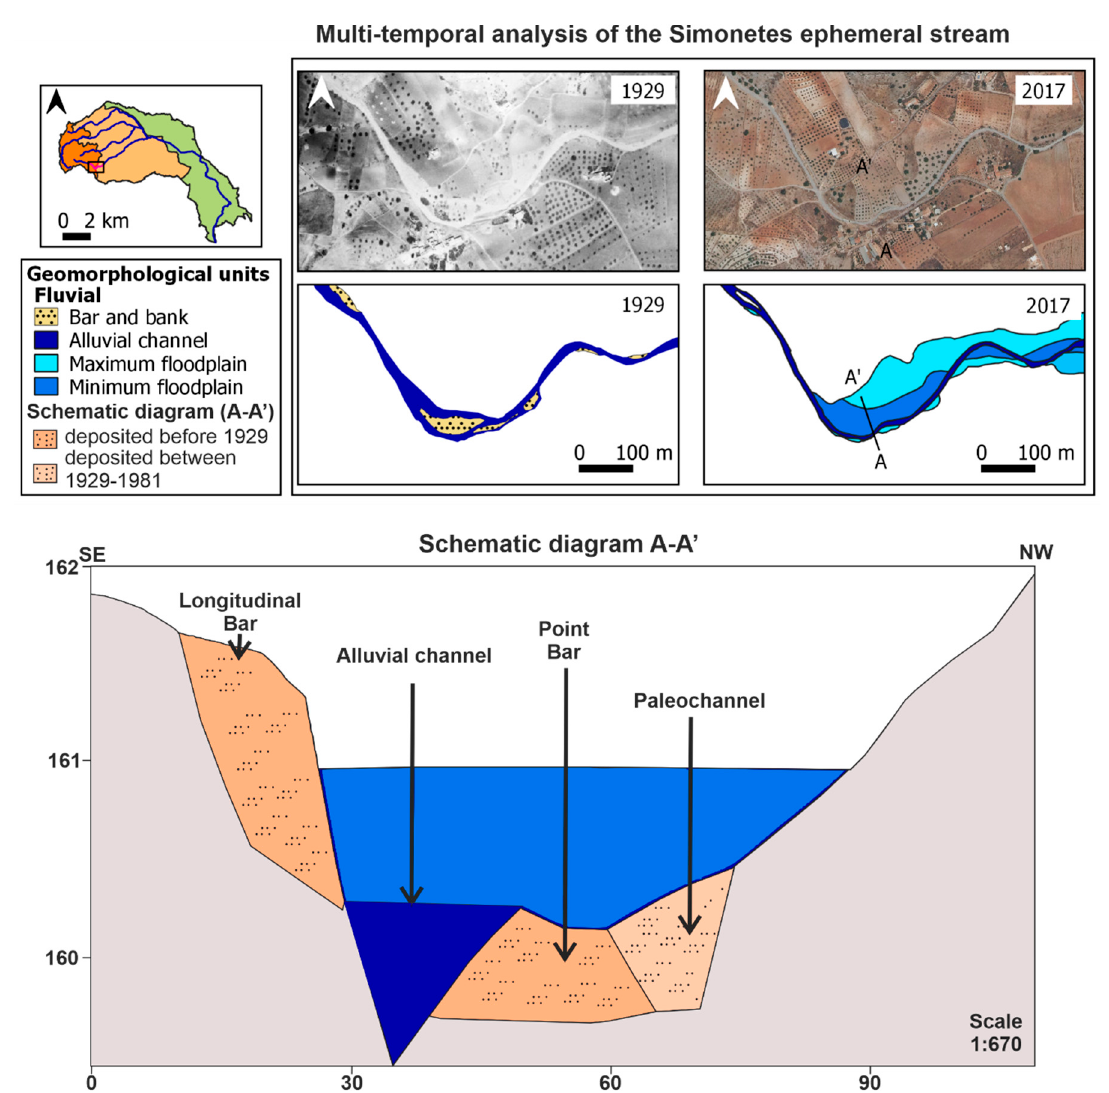
Figure 13. Changes in the fluvial system. In the multi-temporal series, the upper part shows aerial photography in 1929 and 2017, while the lower part shows how the Simonetes ephemeral stream narrowed its channel. The schematic diagram (A-A’) shows the evolution of deposited sediments over time by means of multi-temporal analysis, and in this way the limit of the deposits was inferred.